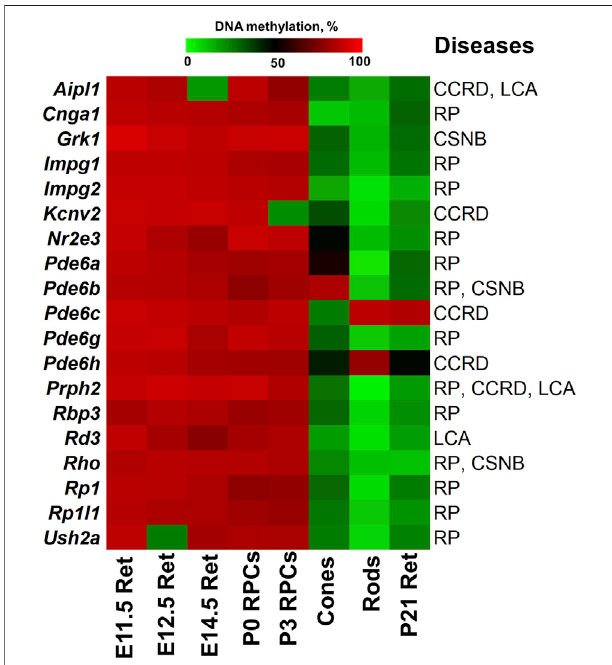
FIGURE 4 | The generated heat map re fl ects DNA demethylation in the promoters of genes associated with RP, CCRD, CSNB, LCA and MD during the differentiation of RPCs into rod and cone photoreceptors. E11.5 Ret, E12.5 Ret, E14.5 Ret correspond to embryonic day (E) 11.5, 12.5 and 14.5 mouse retinas; P0 RPCs and P3 RPCs correspond to RPCs isolated from P0 and P3 retinas; cones and rods correspond to mature cone and